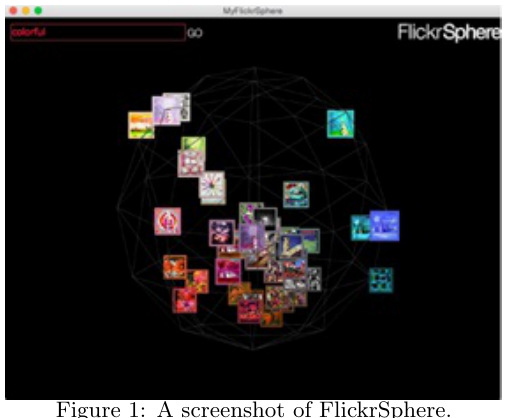
Figure 1: A screenshot of